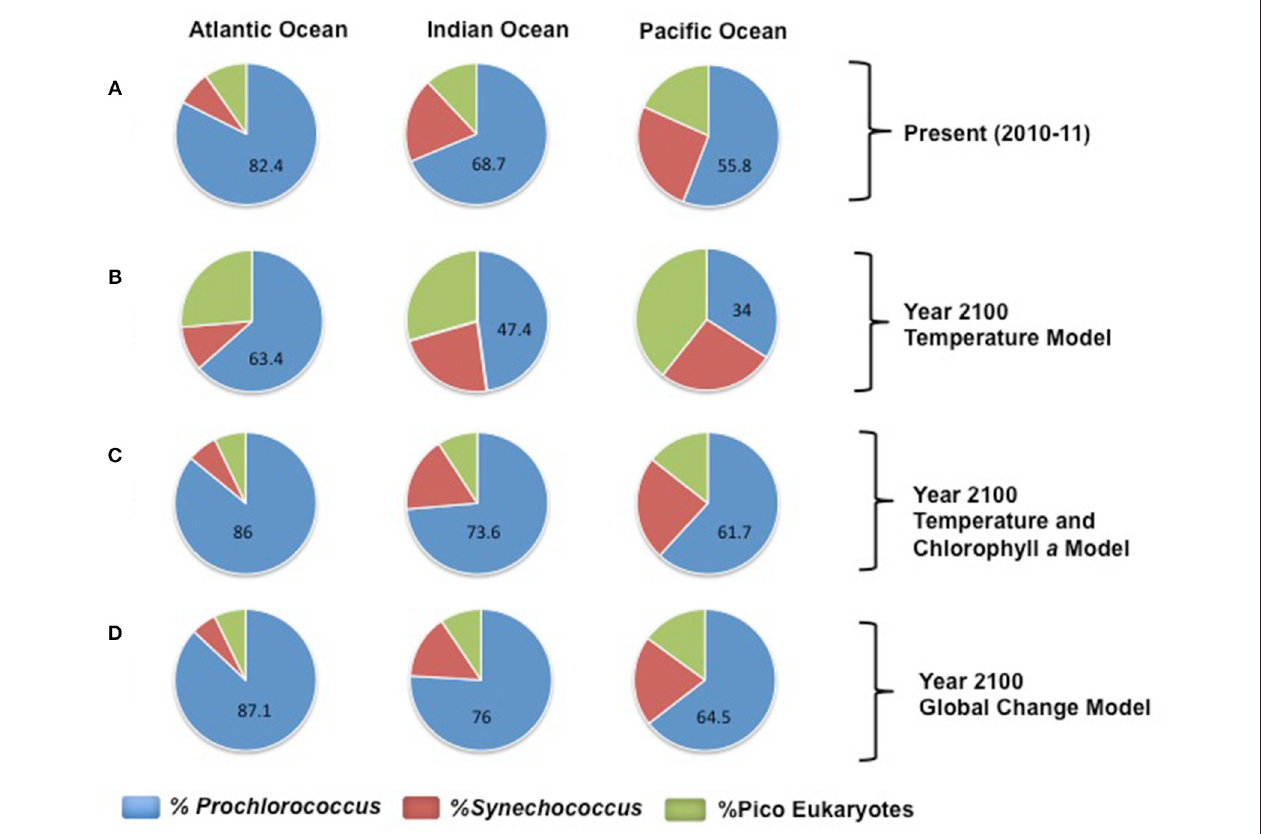
FIGURE 8 | Composition of picoautrophic communities, represented as the average percent contribution to picoautotrophs biomass, in the subtropical waters of the three oceanic basins sampled. The slices in the pie charts are proportional to the percentage of the biomass of Prochlorococcus (blue), Synechococcus (red), and pico-eukaryotes (green), and numbers indicating the percentage of Prochlorococcus . (A) represents the average picophytoautotrophs community in the extant subtropical and tropical ocean, as derived from our survey. (B–D) represent the changes in community composition forecasted for year 2100 by each of the three models (thermal effects, thermals effects and reduced oceanic Chl a , and thermal effects with reduced Chl a and its feedback effects on the submarine light field, under a maximum warming of 2 ◦ C across the subtropical and tropical